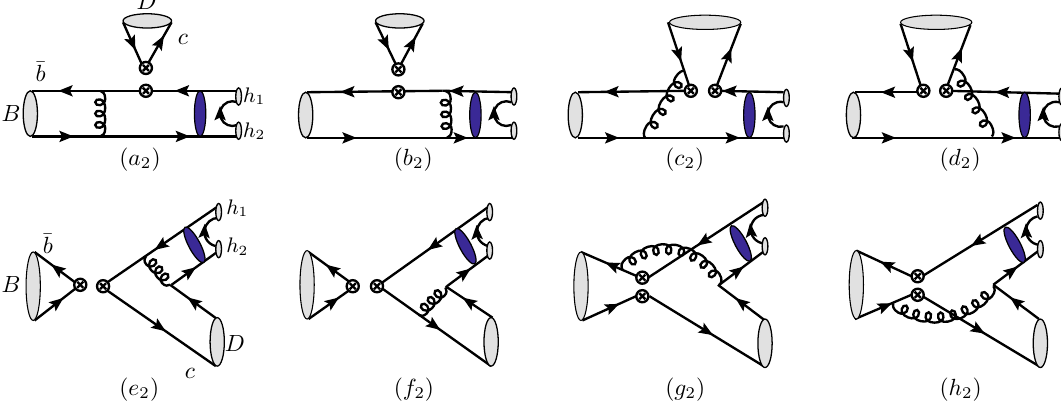
Fig. 2 The leading-order Feynman diagrams for the quasi-two-body decays B ( s ) → D ( s ) K ∗ → D ( s ) K π where B ( s ) =( B 0 , B + , B 0 s ) and D ( s ) =( D 0 , D + , D + s ). The h 1 h 2 denotes the K π pair and the blue ellipse represents the intermediate state K